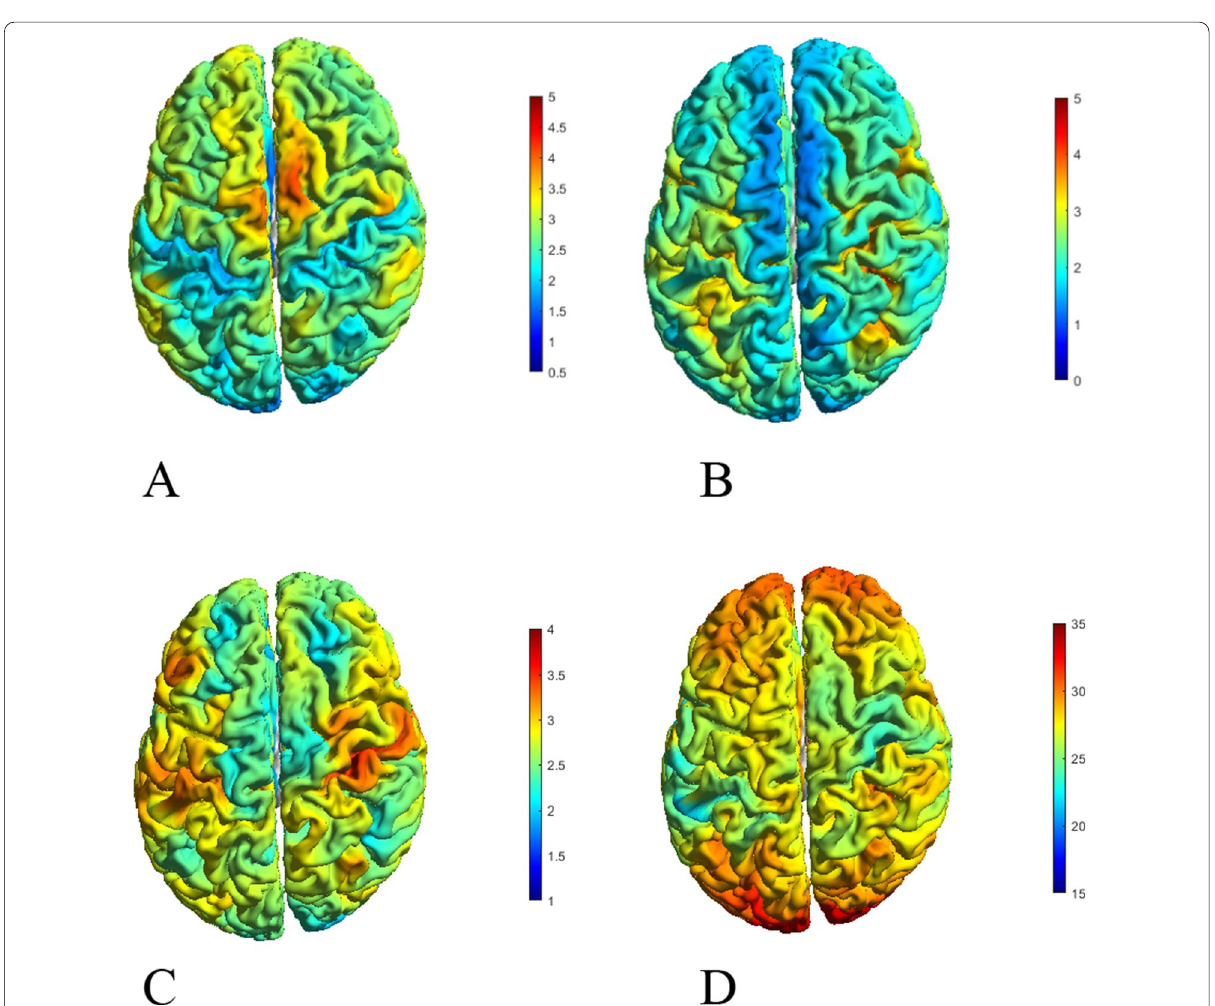
Fig. 4 Maps of surface parameters calculated by Toolbox CAT12. A Cortical thickness, B sulcus depth, C cortical complexity, D